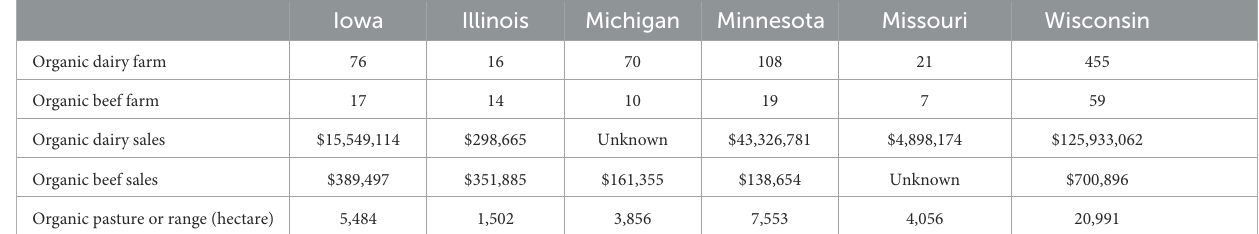
TABLE 1 Number of organic farms, sales, and land area by state in 2016 (USDA National Agricultural Statistics Service, 2017a,b,c,d,e,f).